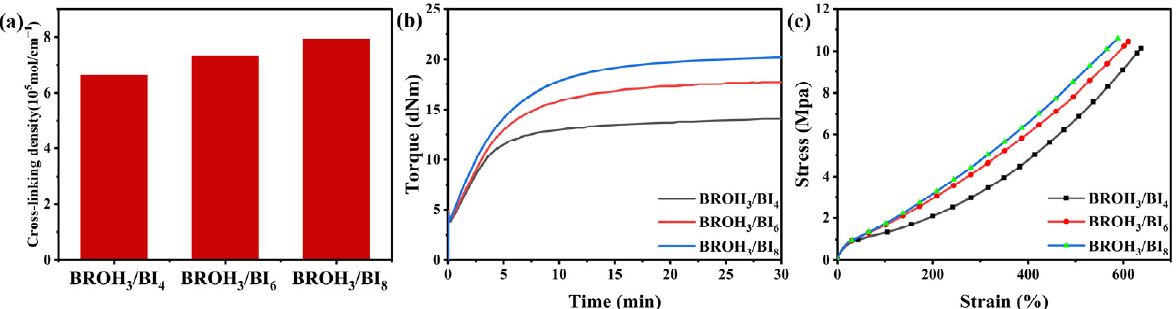
Figure 3. ( a ) crosslink density, ( b ) curing curves, and ( c ) stress − strain curves of BROH 3 cured by different amounts of BI.